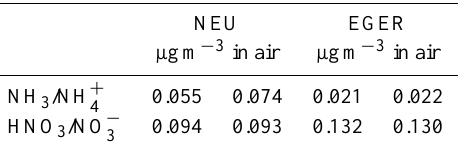
Table 1. Limits of detection (3 σ -definition) for the gas/particle con- centrations determined under field conditions at the two campaign